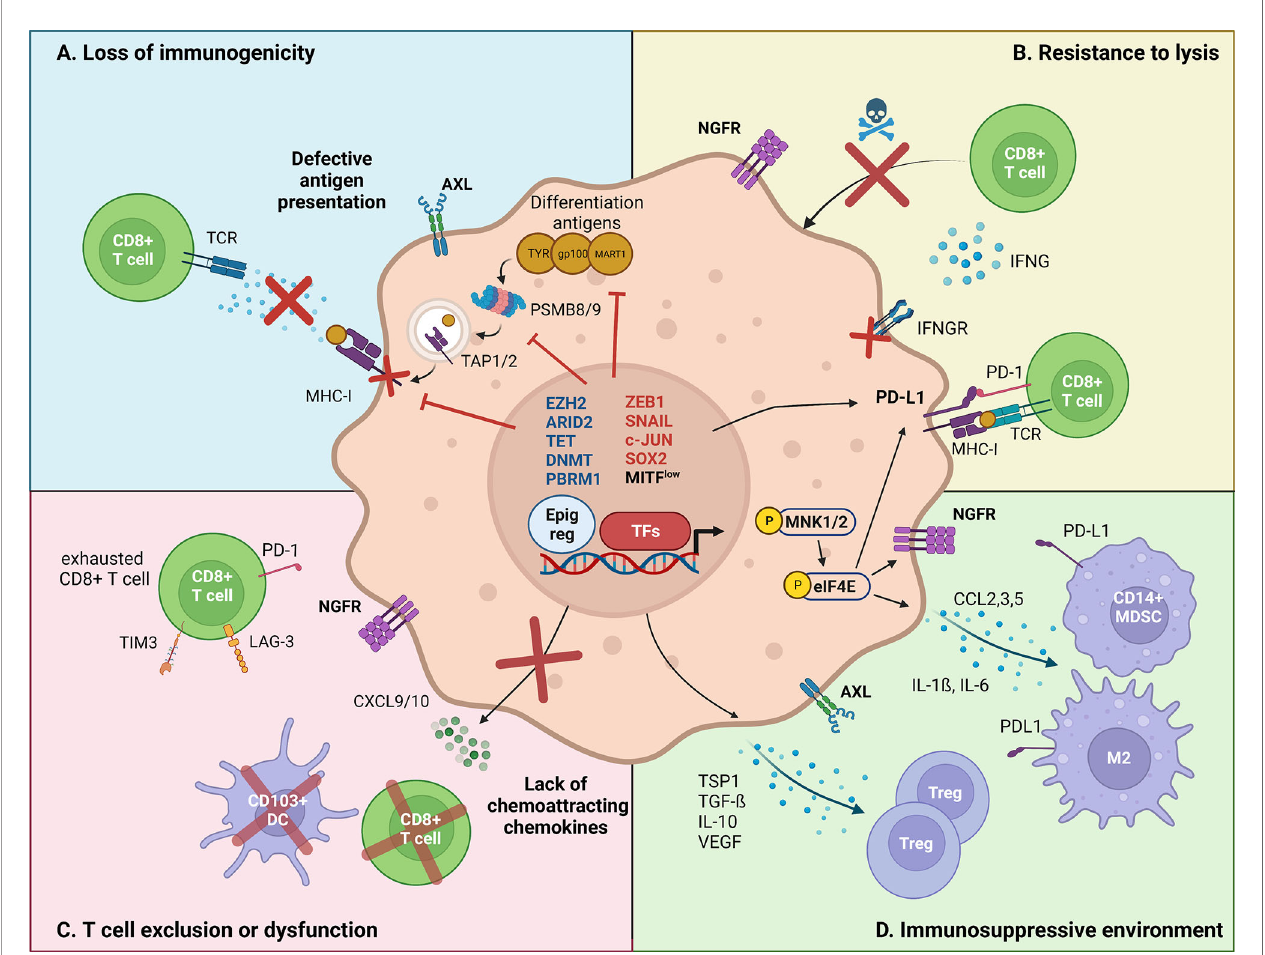
methylation (decreased TET2, upregulated DNMT3A) and chromatin remodeling (ARID2B, PBRM1), promotes the insensitivity to T cell-induced extracellular queues. (C) T cell exclusion/dysfunction. Phenotype switching impacts the recruitment of effector T cells, via reducing the production of chemoattracting chemokines. In particular, ZEB1 has been shown to transcriptionally impair the expression of CXCL10, preventing CD8 + T cell in fi ltration. Other epigenetic actors, such as ARID2 and PBRM1 were found to mediate a similar effect. Additionally, NGFR high melanoma cells are associated with poor TILs in fi ltrate. (D) Immunosuppressive microenvironment. Dedifferentiated melanoma cells have been shown to induce an immunosuppressive and pro-tumoral immune microenvironment. Namely, the MNK1/2-eIF4E axis was shown to increase the translation of CCL2 and CCL5, which attract myeloid-derived suppressor cells (MDSC) and M2 macrophages. Additionally, the EMT-TF SNAIL stimulates the transcription of immunomodulating cytokines such as TSP1 and TGF- b , resulting in an increased in fi ltration of regulatory T